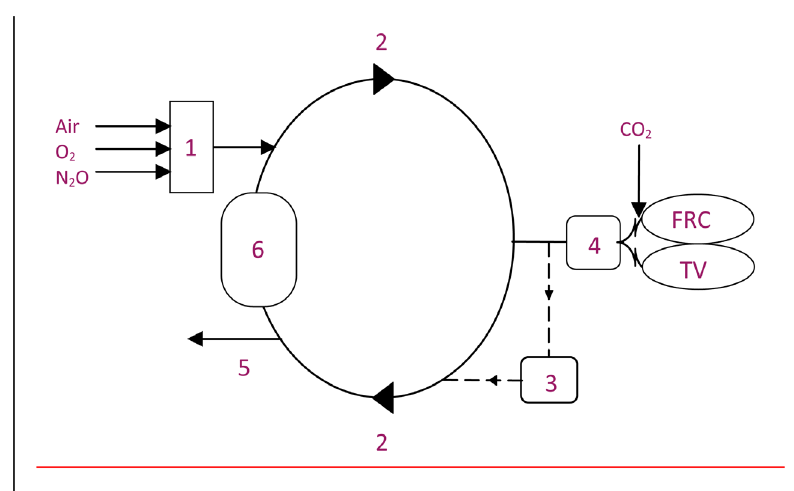
Figure 1. Schematic view of the experimental set-up. The fresh-gas flow is defined in this project as the gas-mixture introduced to the circle i.e. after the vaporizer. The functional residual capacity (FRC) consisted of two reservoir bags. The tidal volume (TV) consisted of one self- deflating bag. A small volume of gas gets diverted through the sidestream sensor but is reintroduced into the circle afterwards. 1. Vaporizer; 2. One-way valves; 3. Sidestream sensor; 4. Mainstream sensor; 5. Spill-valve; 6. CO 2